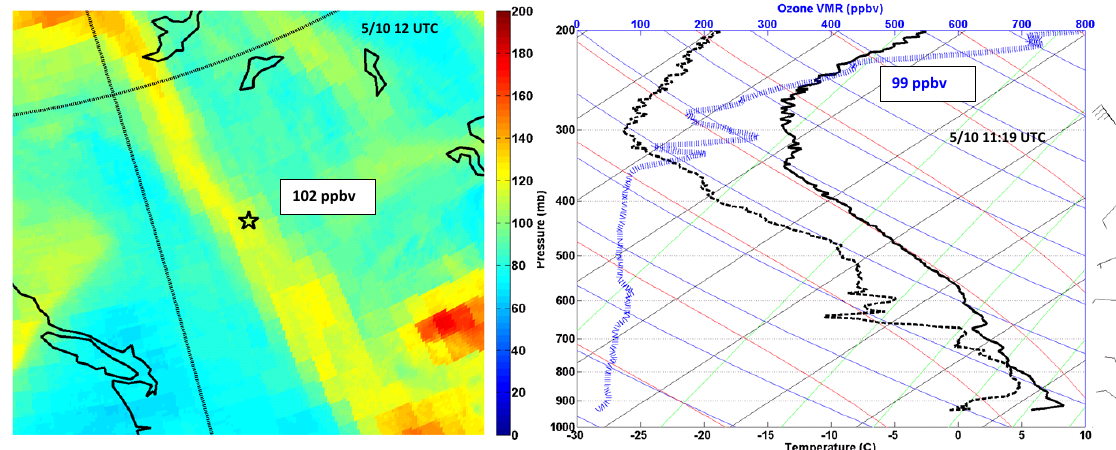
Fig. 8. Images from Edmonton ozonesonde launch on 10 May 2006. (a) The zoomed MUTOP image shows the location of the Edmonton ozonesonde site (black star) within a dry-air streamer UT ozone enhancement. The color bar represents estimated layer-average UT ozone VMR inppbv, indicating a value of 102ppbv for Edmonton. (b) Skew-T plot from the 10 May ozonesonde launch displays column tem- perature (black solid), dewpoint temperature (black dashed), and ozone VMR (blue dashed), indicating a layer average of 99ppbv. Note the ozone enhancement between 400 and 300hPa from tropopause folding is well-captured by coincident MUTOP, and column winds are weak and variable up the 300hPa, suggesting limited sonde drift.